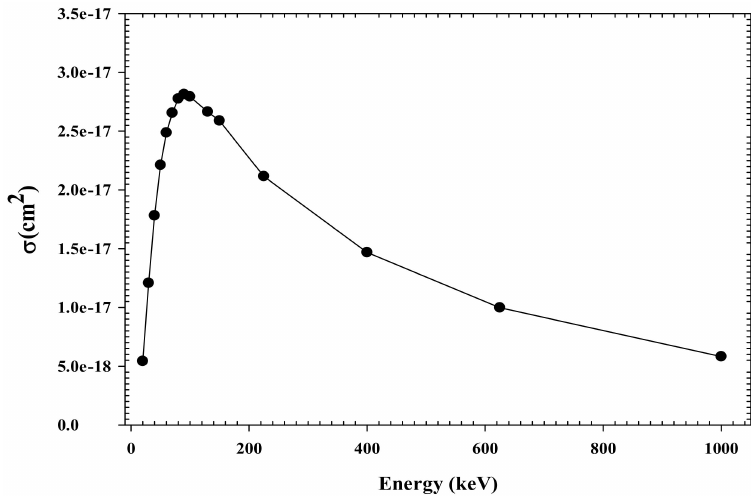
Figure 4. Simultaneous target and projectile ionization cross sections in collision between two ground state hydrogen atoms as a function of projectile impact energy. Filled black circles: present CTMC